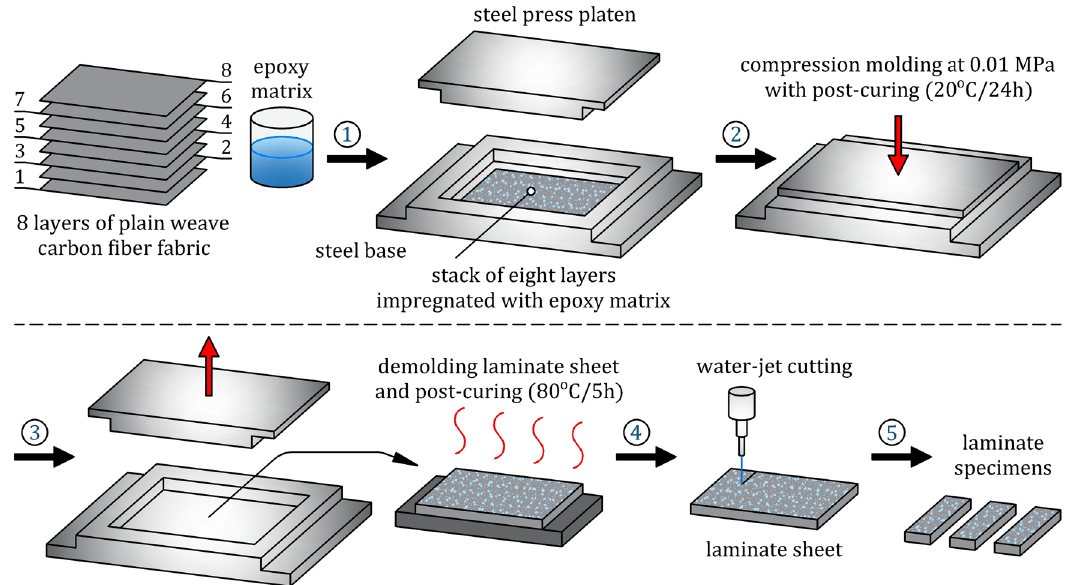
Figure 3: Schematic illustration of the preparation of CL